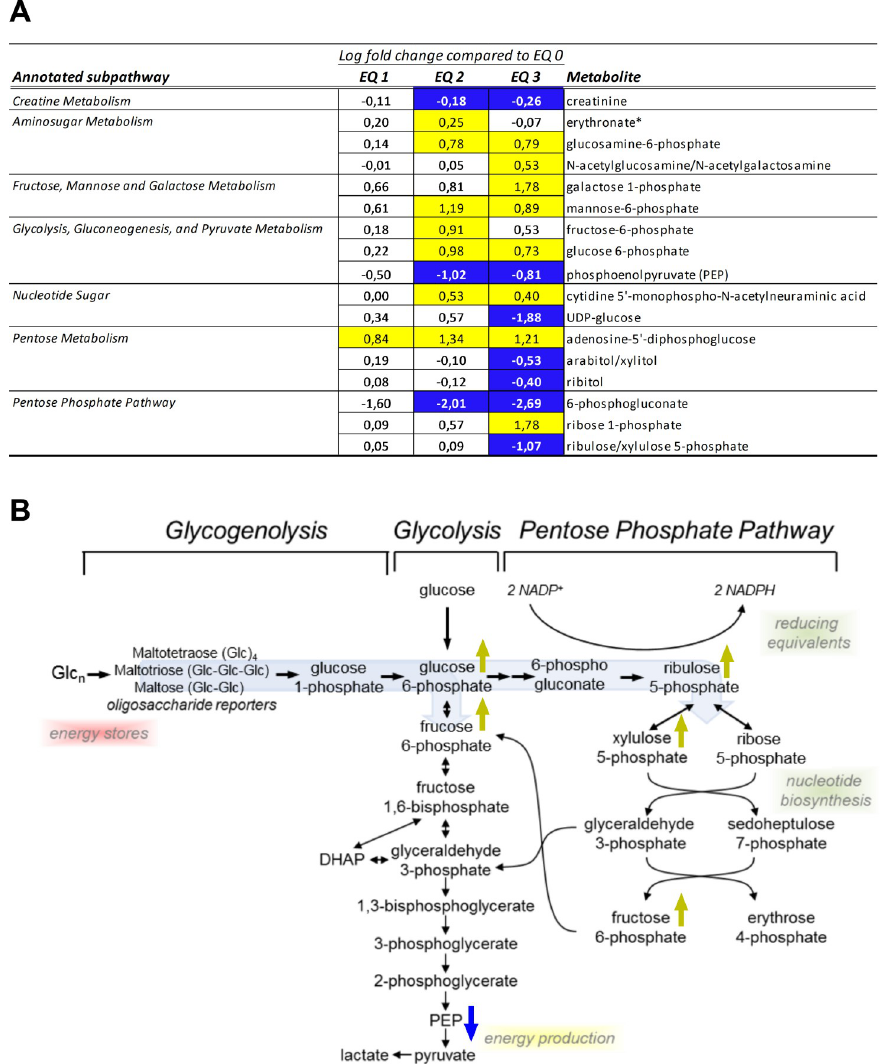
Fig 3. Alterations in liver creatinine levels and carbohydrate metabolism in livers of Atlantic salmon ( Salmo salar L.) exposed to graded levels of ethoxyquin (EQ) through their diet for 90 days. (A) Metabolites displaying differential expression ( p < 0.05, ANOVA) were grouped according to subpathway annotations. Scaled intensity means were used to calculate log2 fold changes in the individual exposure groups compared to unexposed control animals (EQ 0). Significance of change was analyzed through pairwise comparisons between the individual exposure groups and the control, with colors denoting a significantly ( p < 0.05) increased (yellow) or decreased (blue) levels compared to the control. (B) Overview of selected significantly affected carbohydrate metabolites within the pathways of glycogenolysis, glycogenolysis and the pentose phosphate pathway. Metabolites significantly ( p < 0.05) affected by the increasing EQ levels are denoted with yellow (increase) or blue (decrease) arrows. See S4 Table for a complete overview of individual